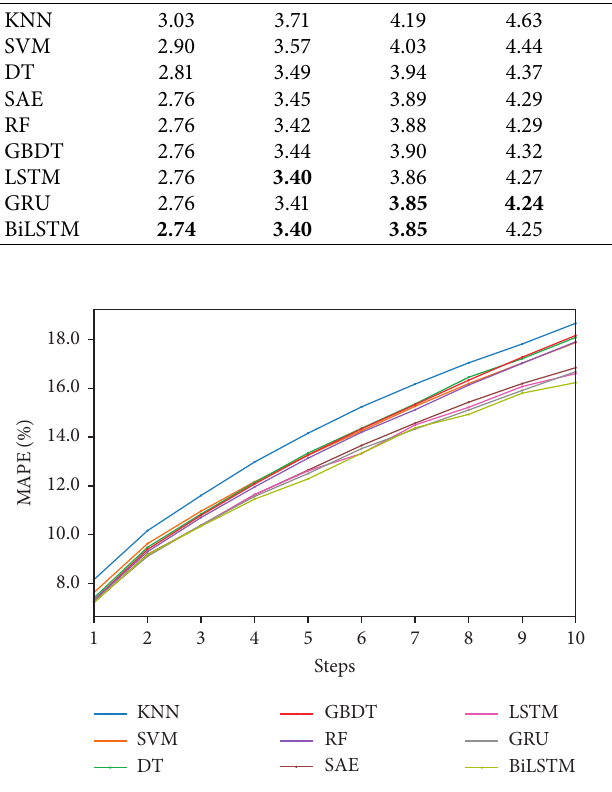
Table 3: Multistep prediction errors of different models on detector 16,395 (MAE).